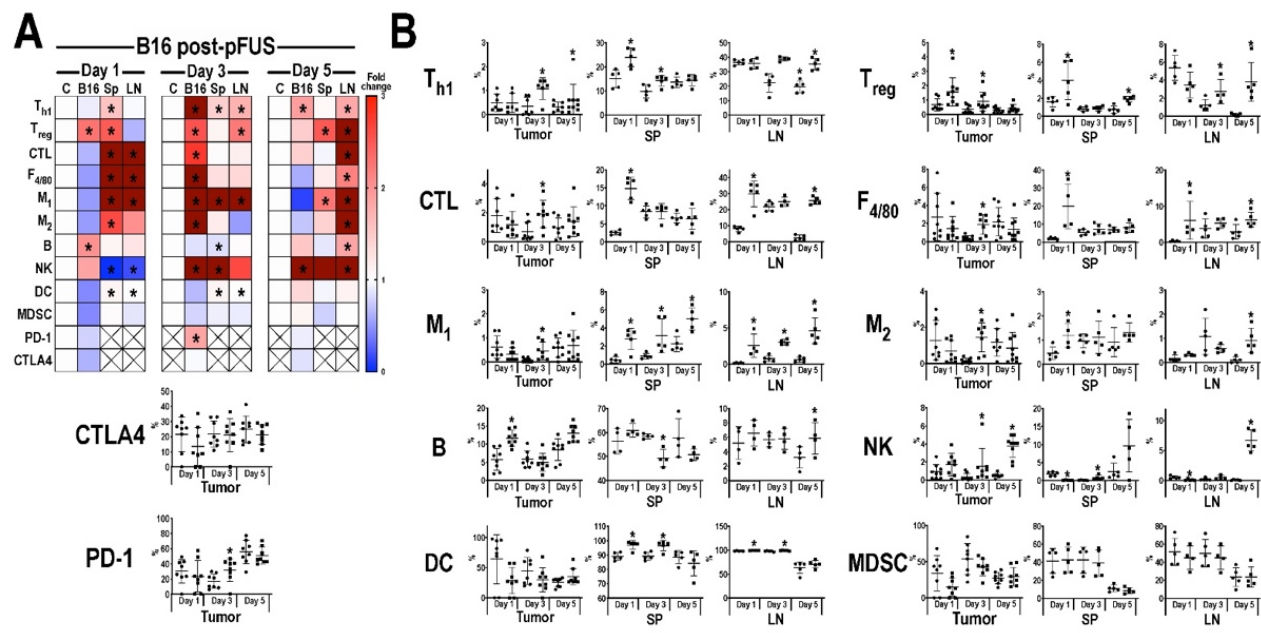
Figure 3. Immune cell profiling following pFUS in B16 tumors. ( A ) Heat map of flow cytometry analysis ( n = 6 mice/time point) for B16 tumor (B16), spleen (Sp) or lymph node (LN) compared to time-matched control tissues. Tissues were harvested 1 (left), 3 (middle), or 5 (right) days following pFUS; Increased fold changes are indicated in red while decreased fold changes are shown in blue. Fold change > 3.1 is displayed as dark red; ( B ) Quantitative values of immune cell profiles (mean ± SD) of mouse B16 tumor, Sp, or LN, dissected 1, 3, or 5 days following pFUS. y -axis represents the relationship between each cell population to the total cells detected; x -axis represents days post-pFUS. Asterisks indicate statistical significance ( p < 0.05; ANOVA) between total cells detected in pFUS-treated mice (black squares) samples to time-matched controls (black circles). Helper T cells (T h1 ), cytotoxic T lymphocytes (CTL), regulatory T cells (T reg ), natural killer (NK) cells, dendritic cells (DC), F 4/80 macrophages (M 1 and M 2 ), myeloid-derived suppressor cells (MDSC), cytotoxic T-lymphocyte antigen 4 (CTLA4), programmed death-1 (PD-1) and programmed death-ligand 1